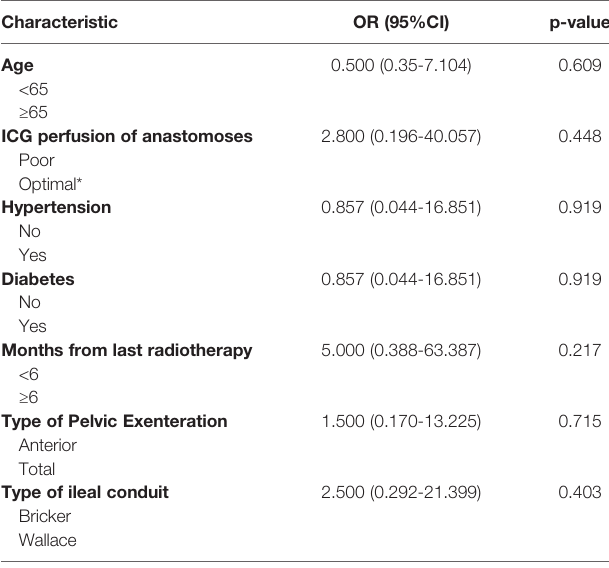
TABLE 4 | Logistic regression analysis of variables associated with 30-day grade 3 – 4 postoperative complications.